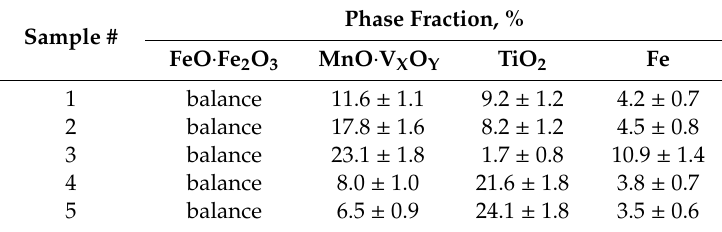
Figure 5. Typical back scattered electron images ( a , b ) of microstructures and contrast histogram ( c ) of the Sample #5 grind; SEM. Table 2. Phase composition of slag samples according to SEM data.